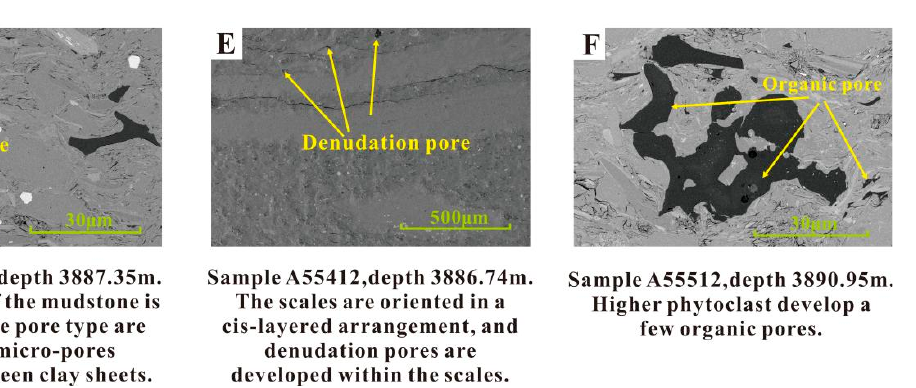
Figure 1. Location ( A ), lithology ( B ), mineral X-ray diffraction ( C ) and argon ion scanning electron microscope ( D – F ) parameters of well A1.